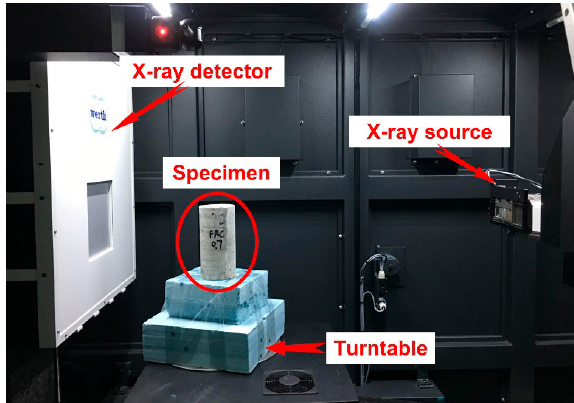
Figure 10. X-ray industrial computed tomography (ICT) scanning system.